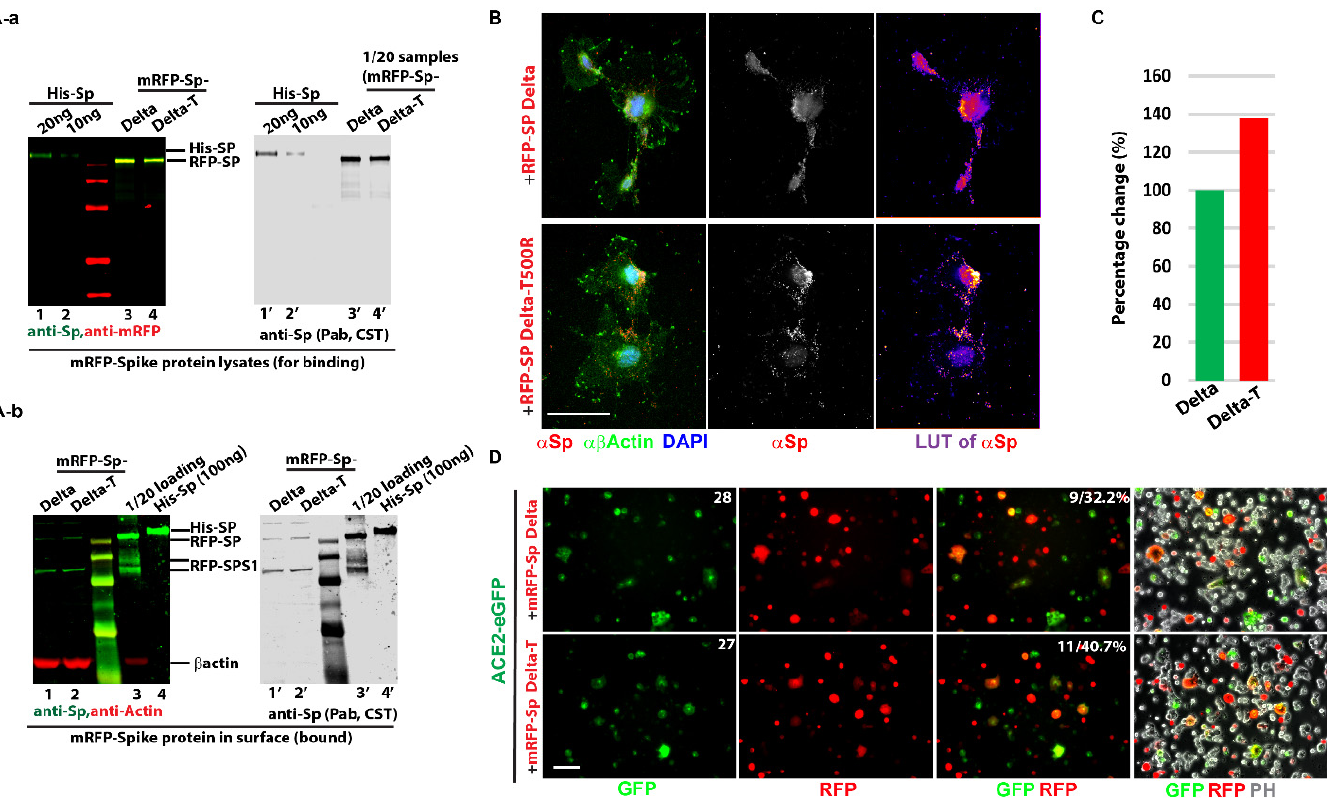
Figure 4. T500R increases the spike protein’s cell-bound affinity. ( A-a ) Quantifications of spike protein Delta variant (Delta) and Delta T500R (Delta-T) in transfected cell lysates (before binding). The purchased His-Sp was loaded for quantification. ( A-b ) More bound spike protein on cells was detected in T500R mutation. Spike proteins (Delta and Delta-T) were added to COS7 cells for bound, and the cell uptake level of spike proteins was checked via WB. Three experiments were repeated. ( B ) T500R mutation resulted in more endosomal entering. Delta and Delta-T were added to COS7 cells on coverslip and stained with actin (green) and spike protein (red) after a one-minute treatment with 0.0025% Trypsin to remove surface unbound ligands. Heatmap (LUT) was presented to indicate the intensity of spike protein’s stain. Warm color means high intensity. ( C ). Graph representation of the ratio of T500R/Delta (Delta-T/Delta) band’s intensity. ( D ) Cell in-fusion assay was performed to show T500R mutation enhances the ACE-2 binding affinity. Cell in-fusion was observed in the combination of ACE2-eGFP with RFP Sp-Delta or Delta-T. The efficacy was calculated as the percentage of Cells No. of “overlap of RFP with GFP”/Cells No. of “GFP”. The number was labeled inside the photos. Scale bar: 20 μ m.